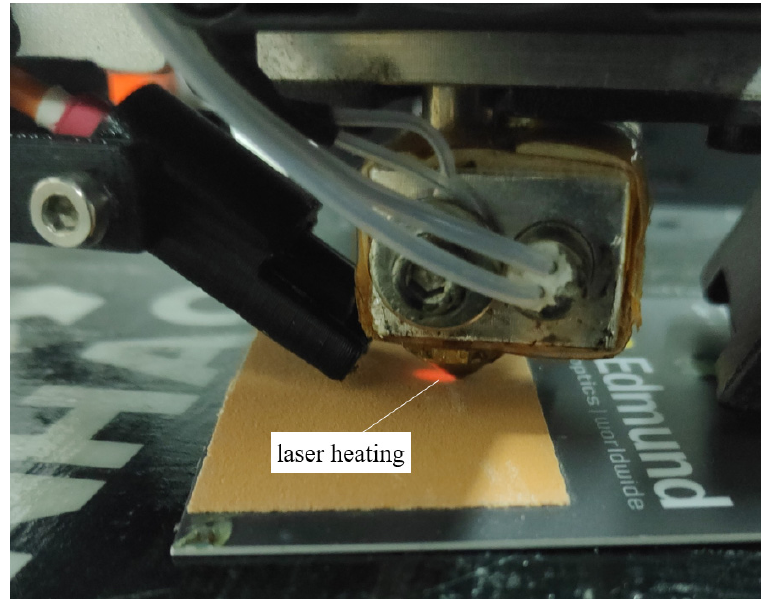
Figure 16. Fixed position of laser heating source relative to the nozzle.